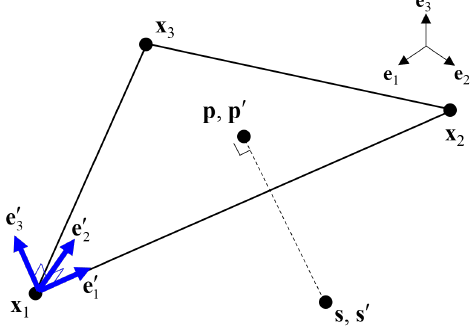
Figure 4. A node of the structural analysis mesh with Cartesian coordinate s , which is to be interpo- lated, and three cell centres of wall-adjacent cells of the CFD mesh, which are closest from the node, with the Cartesian coordinates x 1 , x 2 , and x 3 . (The prime symbol indicates that the coordinates are transformed from the original basis ( e 1 , e 2 , e 3 ) to the basis ( e (cid:48)